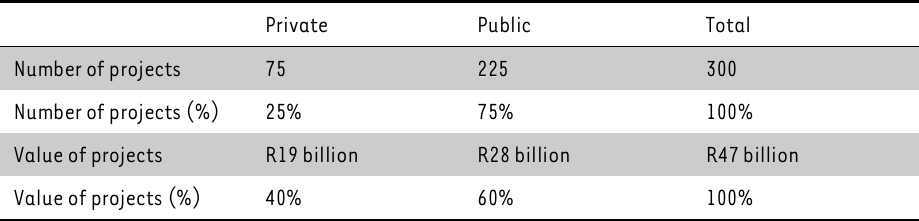
Projects affected by the construction cartel: Private versus Public Private Public Total Number of projects